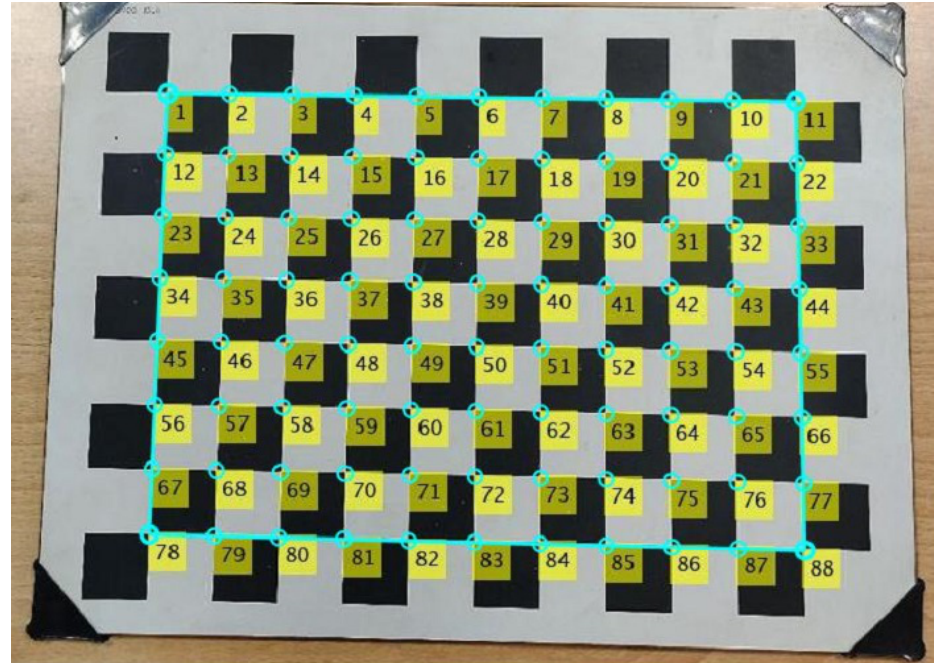
Figure 12. Extraction range of corner points on calibration